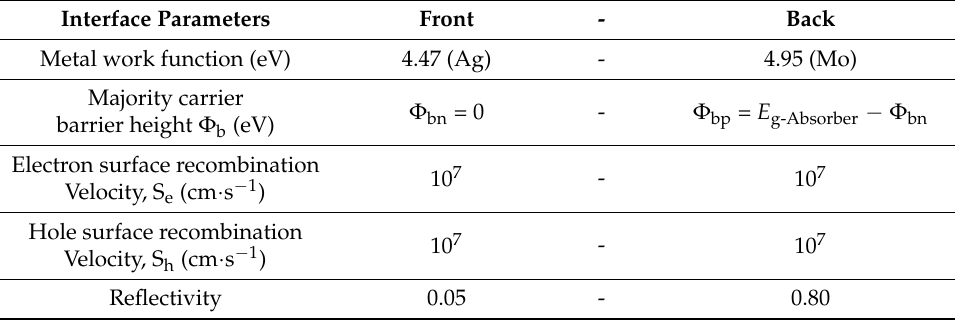
Figure 1. Substrate-type thin film device configuration. Table 1. List of physical and electronic properties for interface parameters